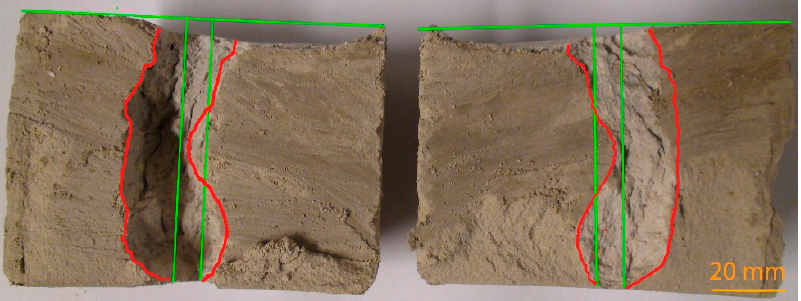
Figure 7. Specimen cross section A–A´ after the test (see Figure 6c)—grout mixture K2 based on Bentovet K (the edge of the failure area in red, the initial hole and inlet side in green).